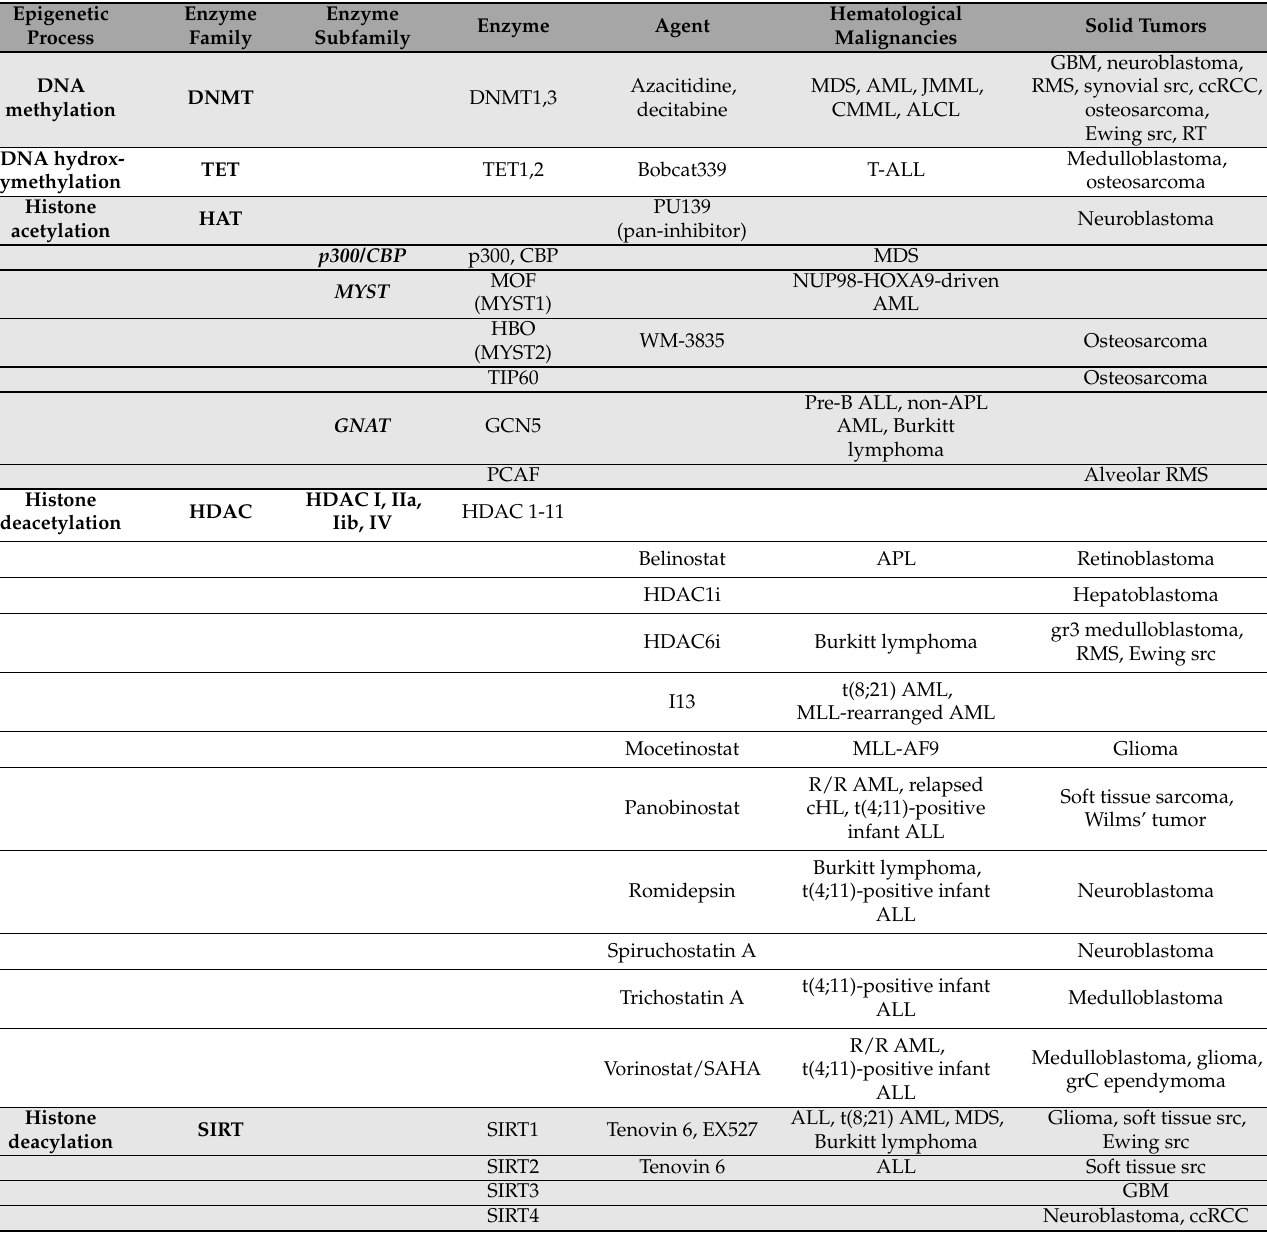
Table 2. Targeted epigenetic interventions in hematological malignancies and solid tumors (see references in the